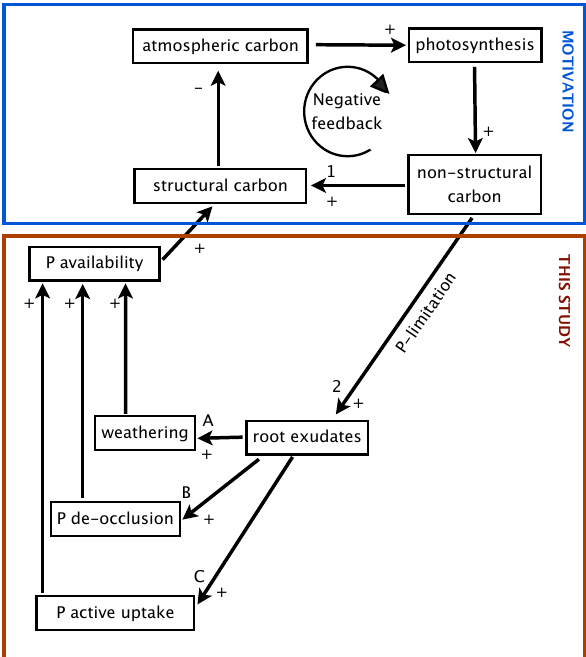
Figure 1. A conceptual diagram showing the feedback processes by which vegetation can affect P cycling in the pedosphere and the C cycle. Plants with abundant P supply can sequester carbon from the atmosphere and store it in biomass (path 1), which results in an overall negative feedback on atmospheric CO 2 concentrations. P-limited vegetation has a reduced capacity for producing biomass. Instead, it builds up non-structural carbon reserves that can lead to increased root exudation into the soil (path 2). Increasing root exu- dates increases soil respiration, potentially leading to (A) enhanced rock weathering; (B) P de-occlusion from the secondary minerals; or (C) more efficient P uptake by means of symbiosis with root my-